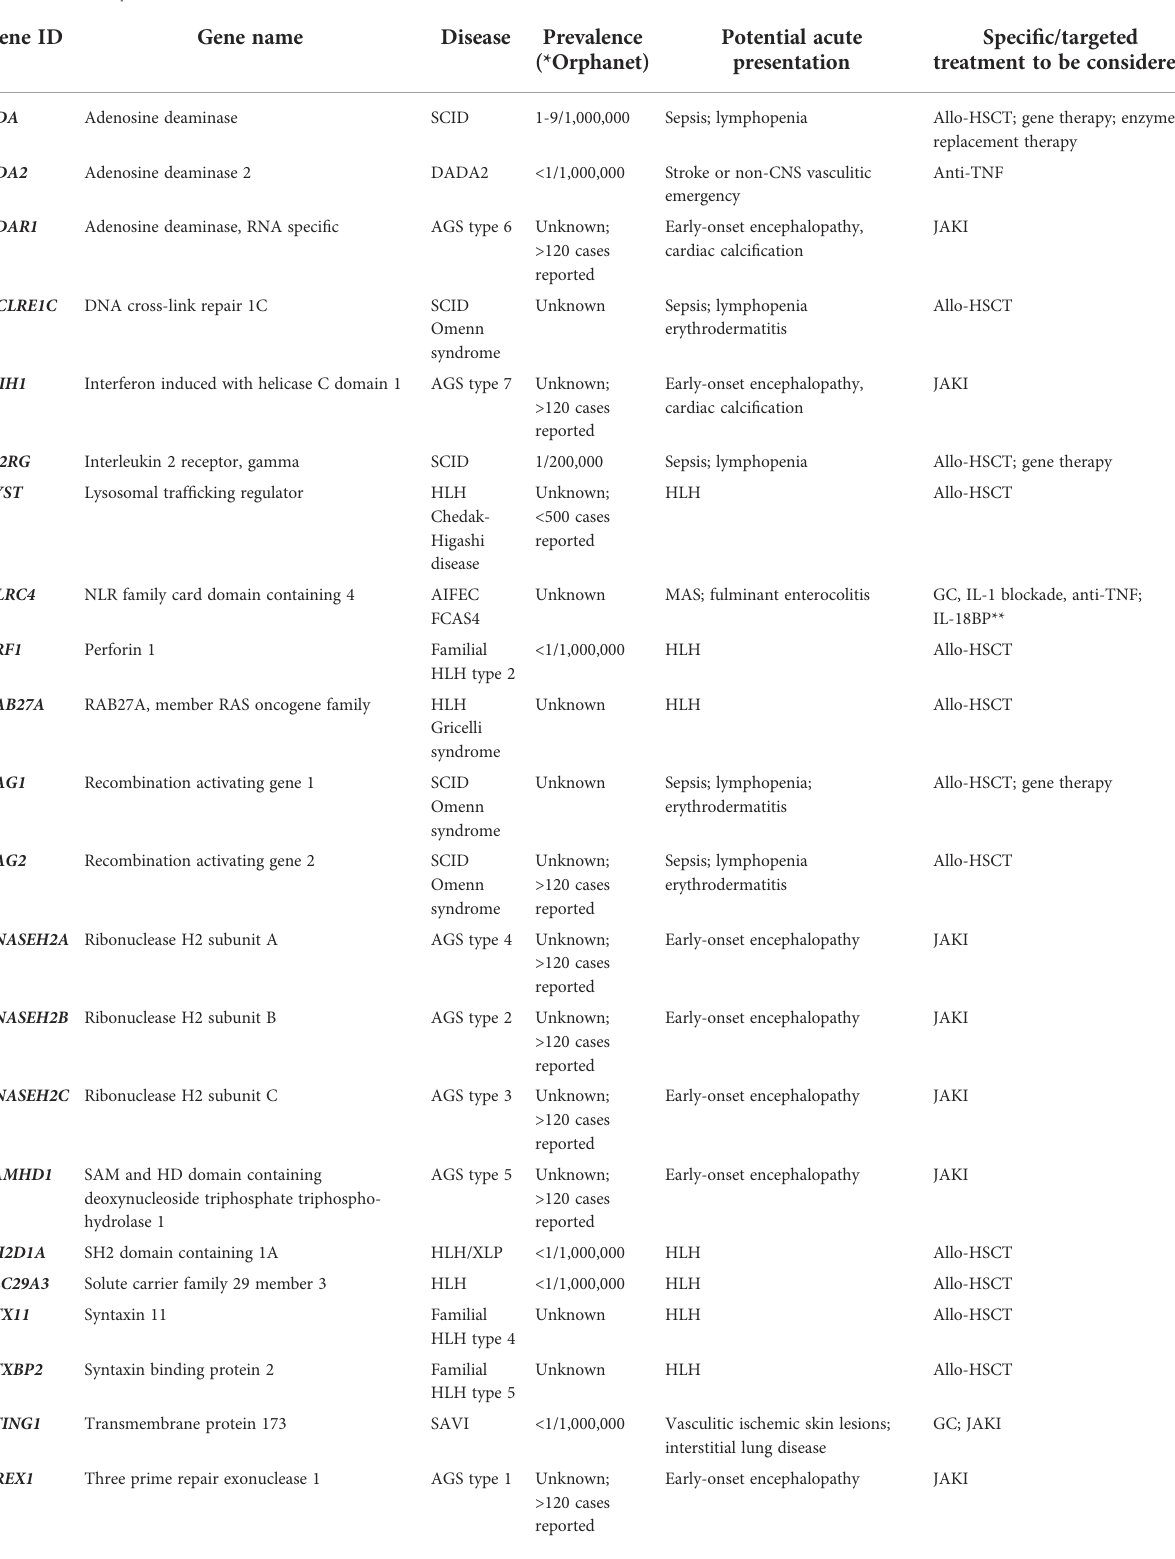
TABLE 1 The Rapid Autoin fl ammation Panel